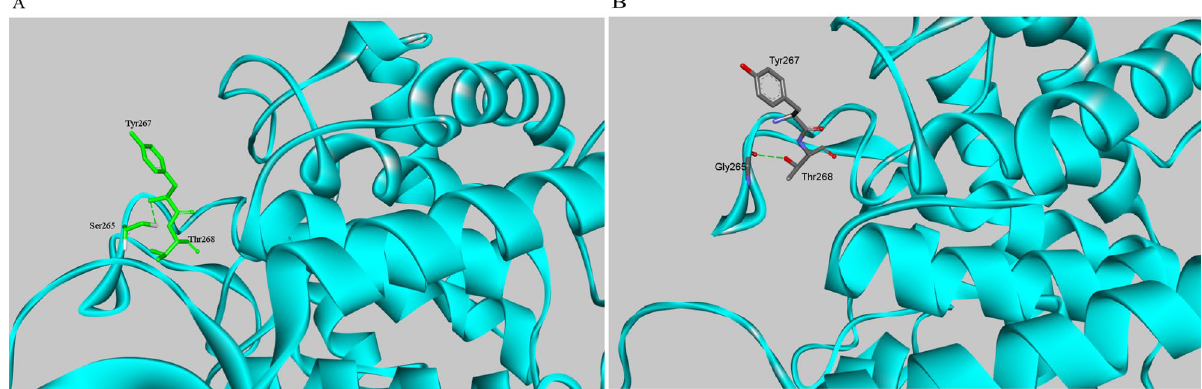
Figure 4. Changes of intramolecular interactions of residue 265 with the nearby residues after S265G mutation. The intramolecular interactions were displayed with Discovery Studio 4.1. The proteins were shown in cyan. The residue Ser265 is shown in green and Gly265 is shown in gray according to the stick representation scheme. The dotted line corresponds to the intramolecular interactions. ( A ) Wild-type. ( B )